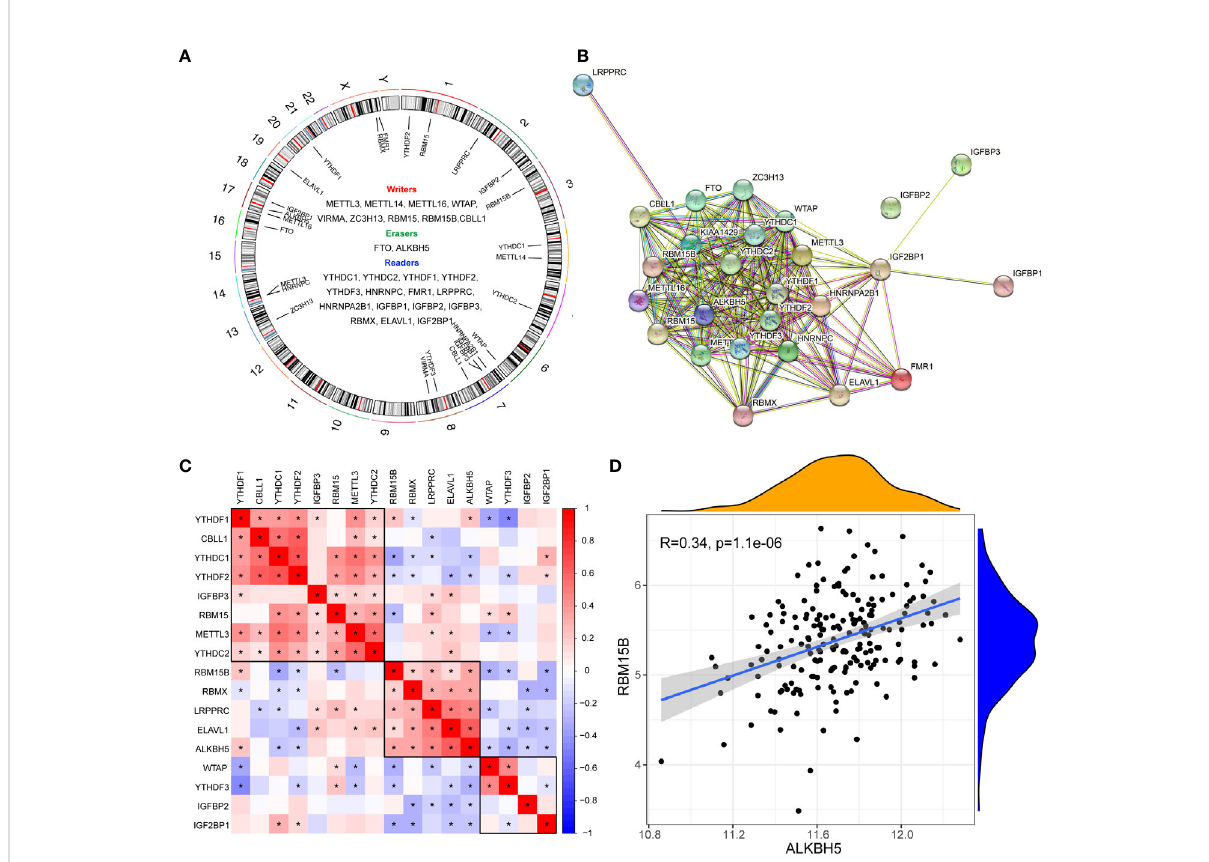
FIGURE 1 Expression landscape of m6A regulators in primary Sjögren ’ s syndrome. (A) Circus diagram indicating the location of m6A regulators in the chromosome. (B) The protein-protein interaction network of m6A regulators. (C) The correlations among the expression of 27 m6A regulators in pSS PB samples. (D) The scatter plot demonstrated the correlations between dysregulated m6A “ writers ” and m6A “ erasers ” with r>0.3 and p<0.01; *,